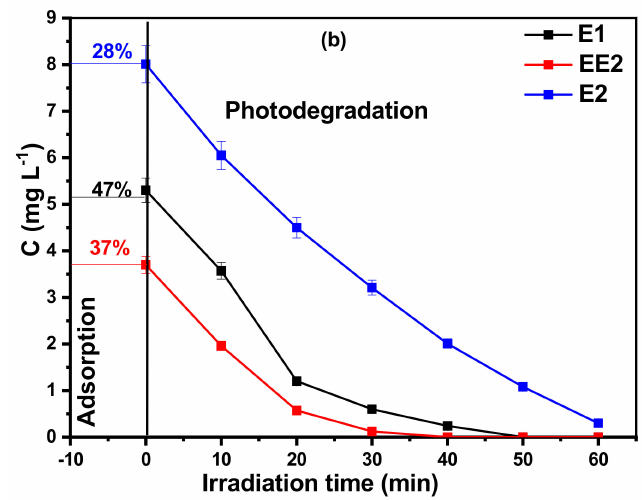
Figure 8. Hormone concentration as a function of time in the presence of AC/TiO 2 -b 53% and in wastewater effluent: ( a ) in the dark and ( b ) after the adsorption step and under UV light irradiation. [AC/TiO 2 -b 53%] = 0.13 g L − 1 , [E1] = 10 mg L − 1 , [EE2] = 5.8 mg L − 1 et [E2] = 11.2 mg L − 1 , pH = 7, T = 25 ◦ C, [O 2 ] = medium, Xe lamp 300